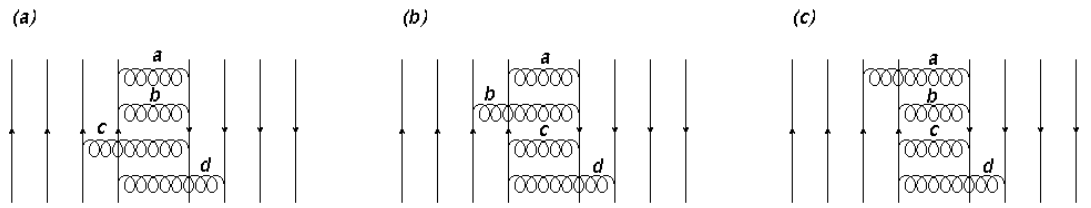
Figure 12 . Examples of diagrammatic contributions with 2 o(cid:11)-diagonal and 2 diagonal gluons that are all connected to the same pair of sources. The three diagrams di(cid:11)er by the number of 0, 1 and 2 diagonal gluons placed in between the o(cid:11)-diagonal gluons, and this changes the color trace, see text for